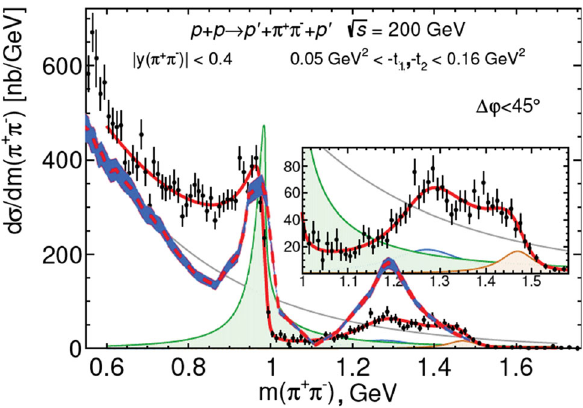
Fig. 7 The new data on the process p + p → p + π + + π − + p √ s = 200 GeV (STAR collaboration [23–25]): | y ππ | < 0 . 4, at 0 . 05 GeV < | t 1 , 2 | < 0 . 16 GeV 2 , φ 0 < 45 o . Solid curves represent fits from experimental papers [23–25] extrapolated to the full kinematic region. The thick dashed curve corresponds to parameters, fixed from the old data from STAR depicted in Fig. 5 and explained in the text: Λ π = 1 . 2 GeV in the off-shell pion form factor (11) and couplings from (14). The thickness of the solid curves corresponds to the errors of Monte Carlo calculations. Additional interpolation was used between calculated points for smoothing